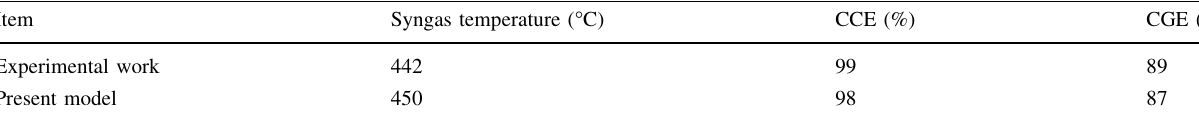
Table 12 Comparison between experimental and current simulation results